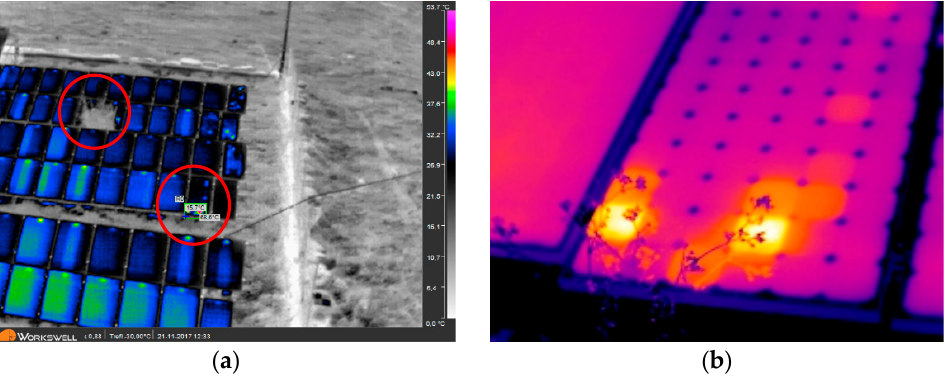
Figure 7. Thermographic analysis for an incident of partial shading: ( a ) aerial IR inspection, and ( b ) ground-level IR inspection. The red circles in ( a ) identify the affected PV modules.